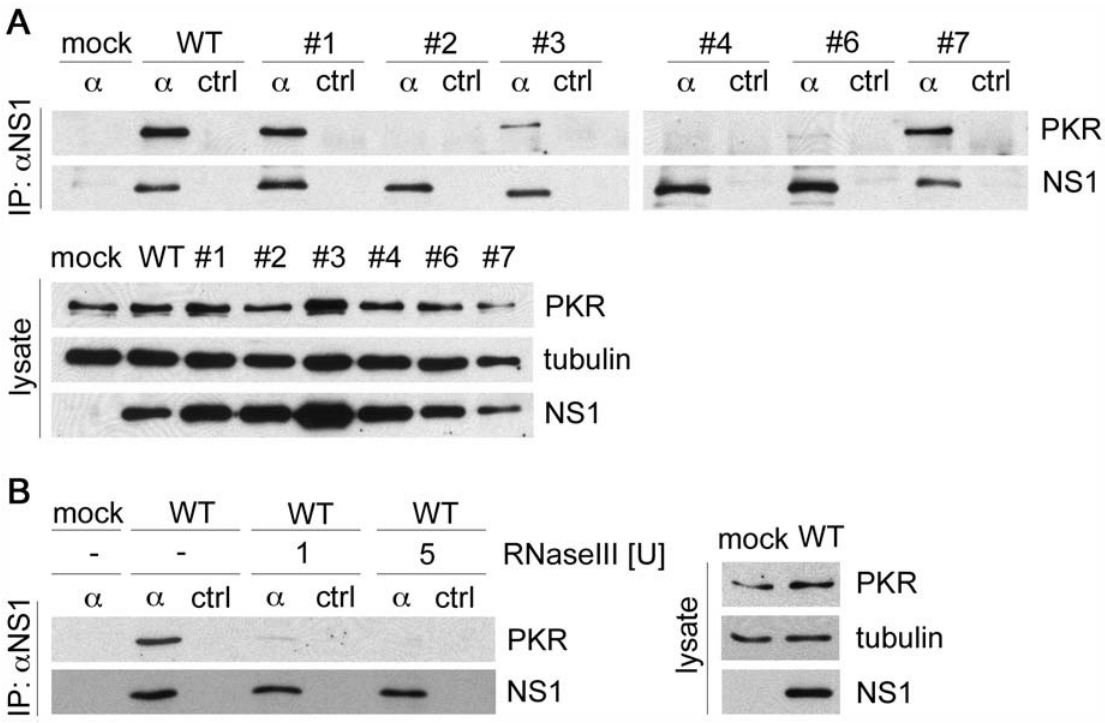
Figure 2. The dsRNA-binding activity of the NS1 protein mediates interaction with PKR. (A) Human A549 lung epithelial cells were mock treated or infected with WT virus or the NS1 mutant viruses # 1, # 2, # 3, # 4, # 6 or # 7 at an MOI of 1. Lysates were subjected to immunoprecipitation (IP) with NS1 antiserum ( a ) or pre-serum (ctrl). The precipitated complexes were analyzed by immunoblotting with antibodies specific for PKR (upper panel) and NS1 (lower panel). Whole cell lysates were also analyzed with antibodies specific for PKR, tubulin and NS1 as indicated. (B) A549 cells were mock treated or infected with WT virus at an MOI of 1. Lysates were prepared that were either mock treated ( 2 ) or treated with the indicated amounts of RNase III for 10 minutes at 33 u C prior to immunoprecipitation with NS1 antiserum ( a ) or pre-serum (ctrl). The precipitates were analyzed as described in panel 2A (panel to the left). Aliquots of the lysates were also analyzed directly by immunoblotting for PKR, tubulin and NS1 as indicated (panels to the